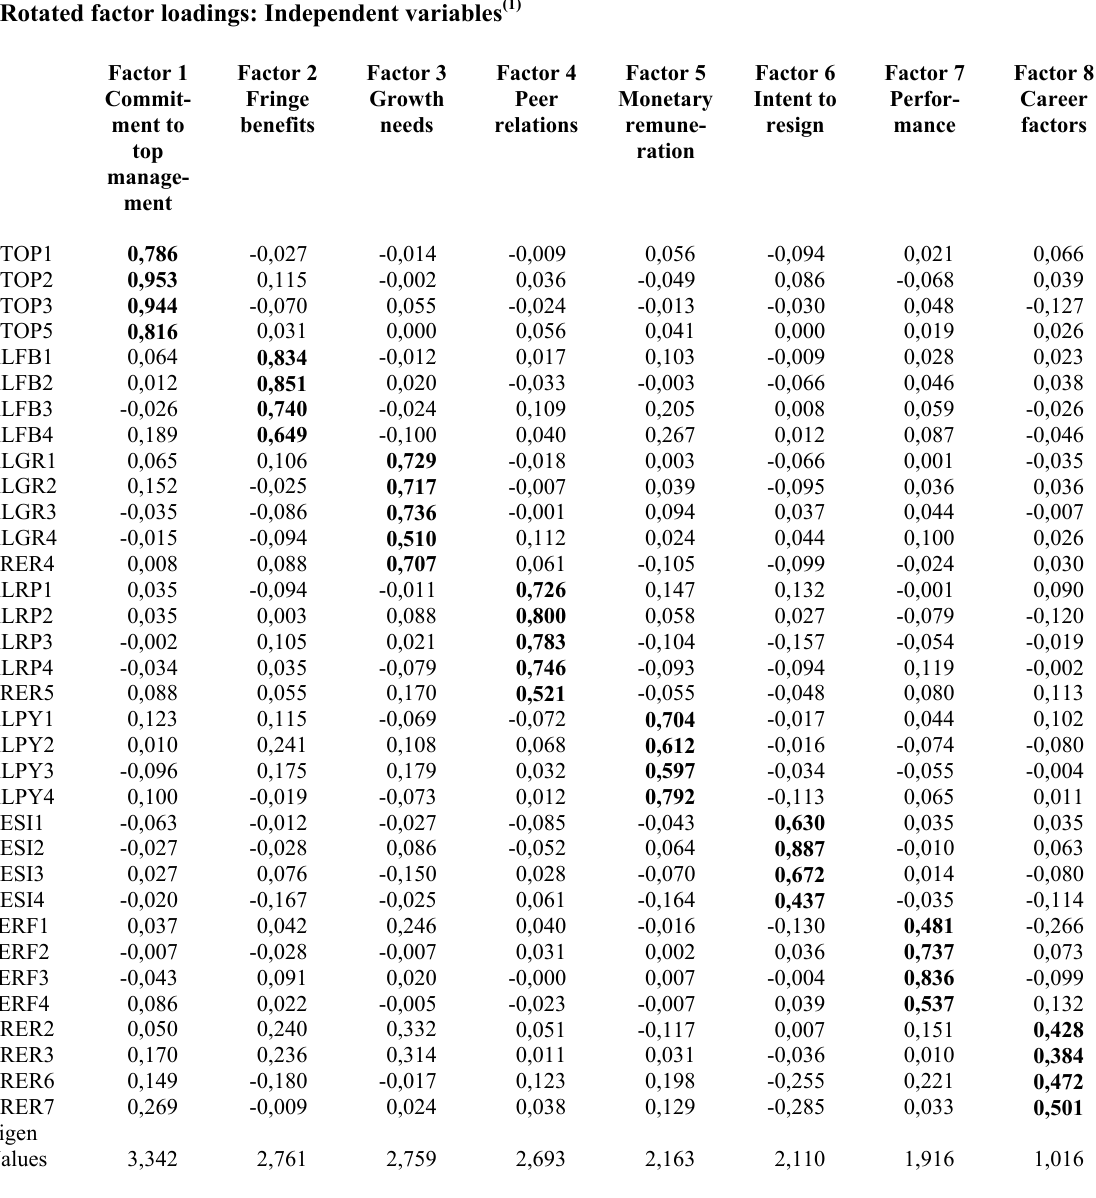
Table 2 Rotated factor loadings: Independent variables